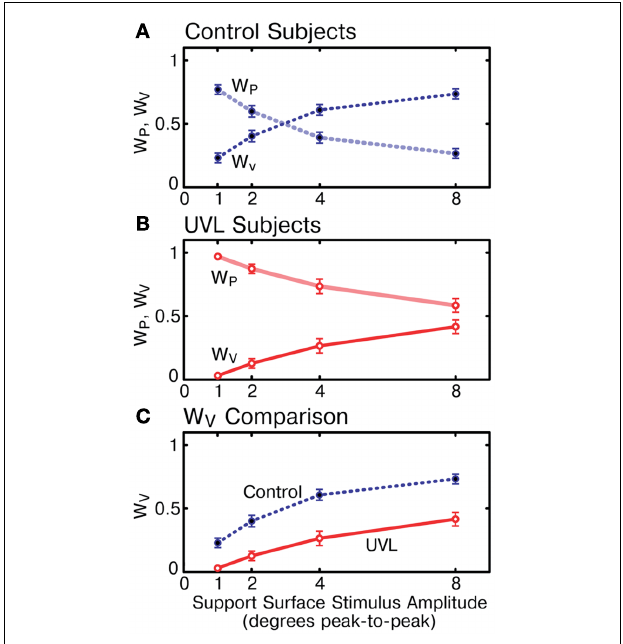
FIGURE 4 |Vestibular ( W V ) and proprioceptive ( W P ) weights vary as a function of support surface stimulus amplitude for control subjects and unilateral vestibular loss subjects. (A) Mean W V and W P values for control subjects. (B) Mean W V and W P values for unilateral vestibular loss subjects. (C) Comparison of W V for controls and unilateral vestibular loss subjects. Mean W V values in unilateral vestibular loss subjects were always less than in control subjects and never exceeded 0.5 (50% reliance on vestibular information). Means ± SE are plotted ( N = 11 subjects in each group).